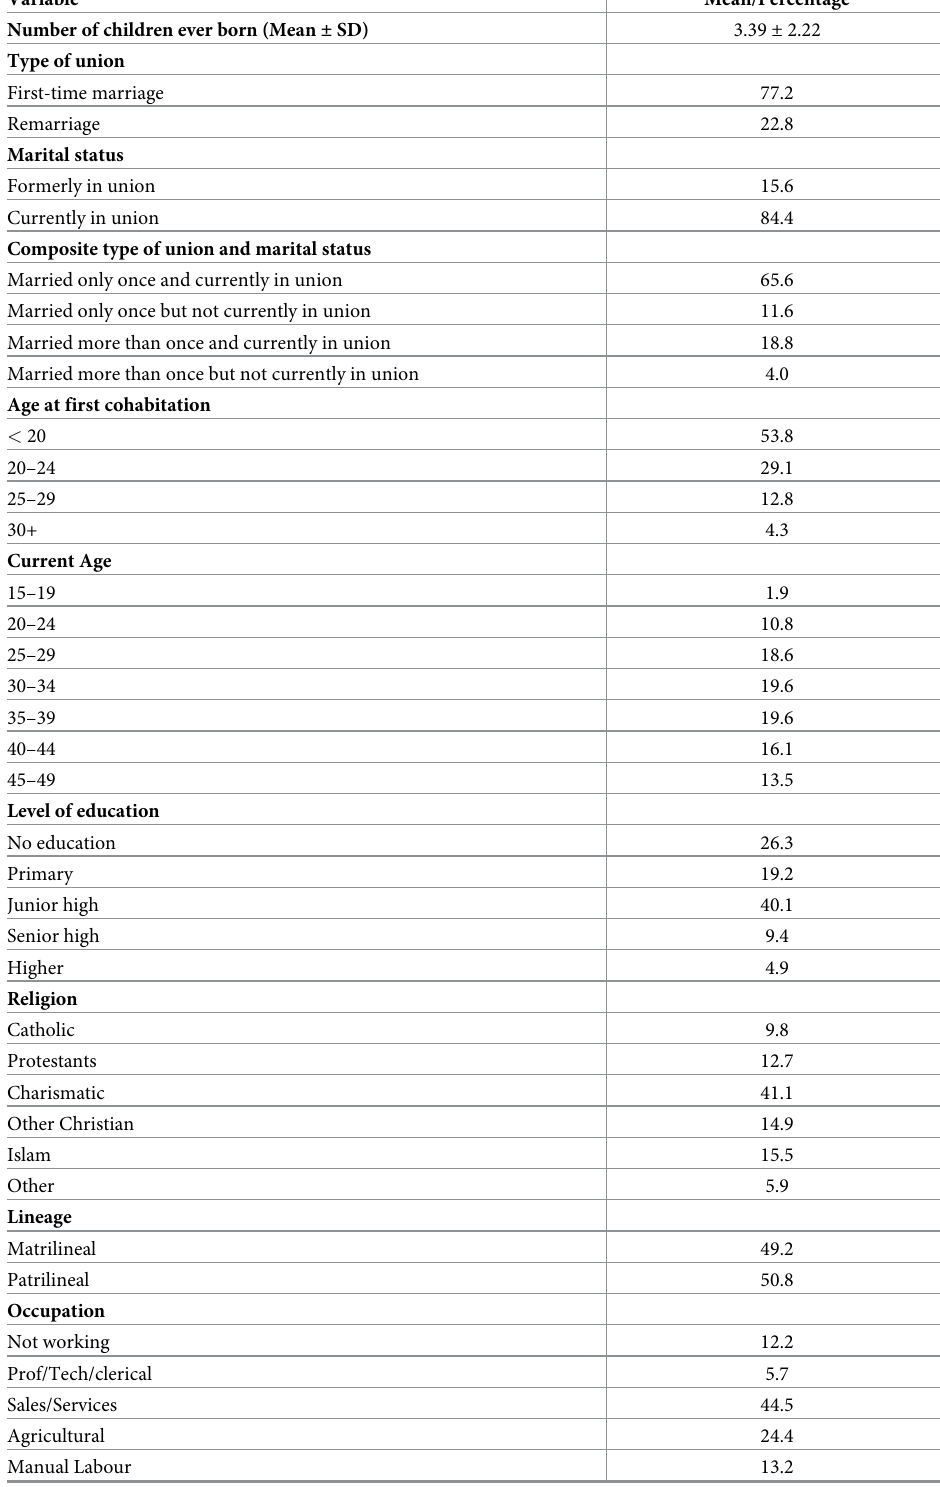
Table 1. Background characteristics of